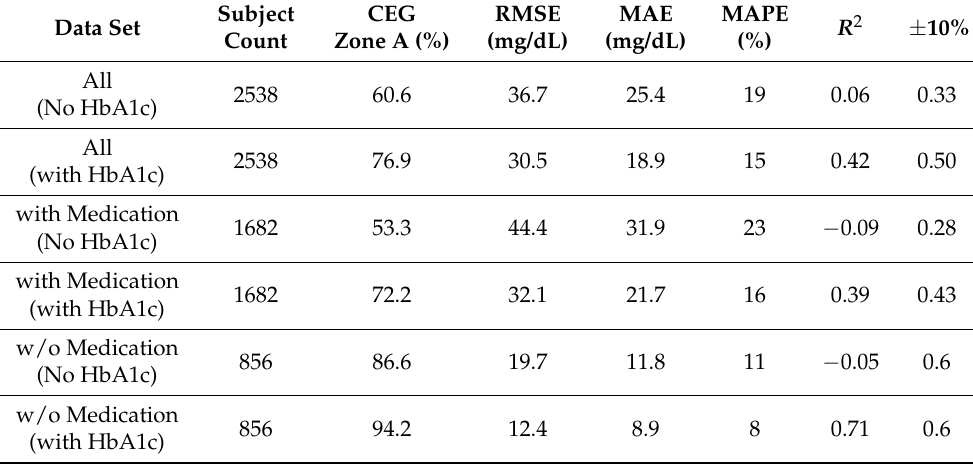
Table 3. Summary of model